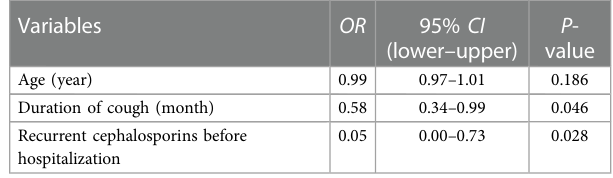
TABLE 3 Logistic regression analysis of predictors of “ remission ” of PBB children. Variables